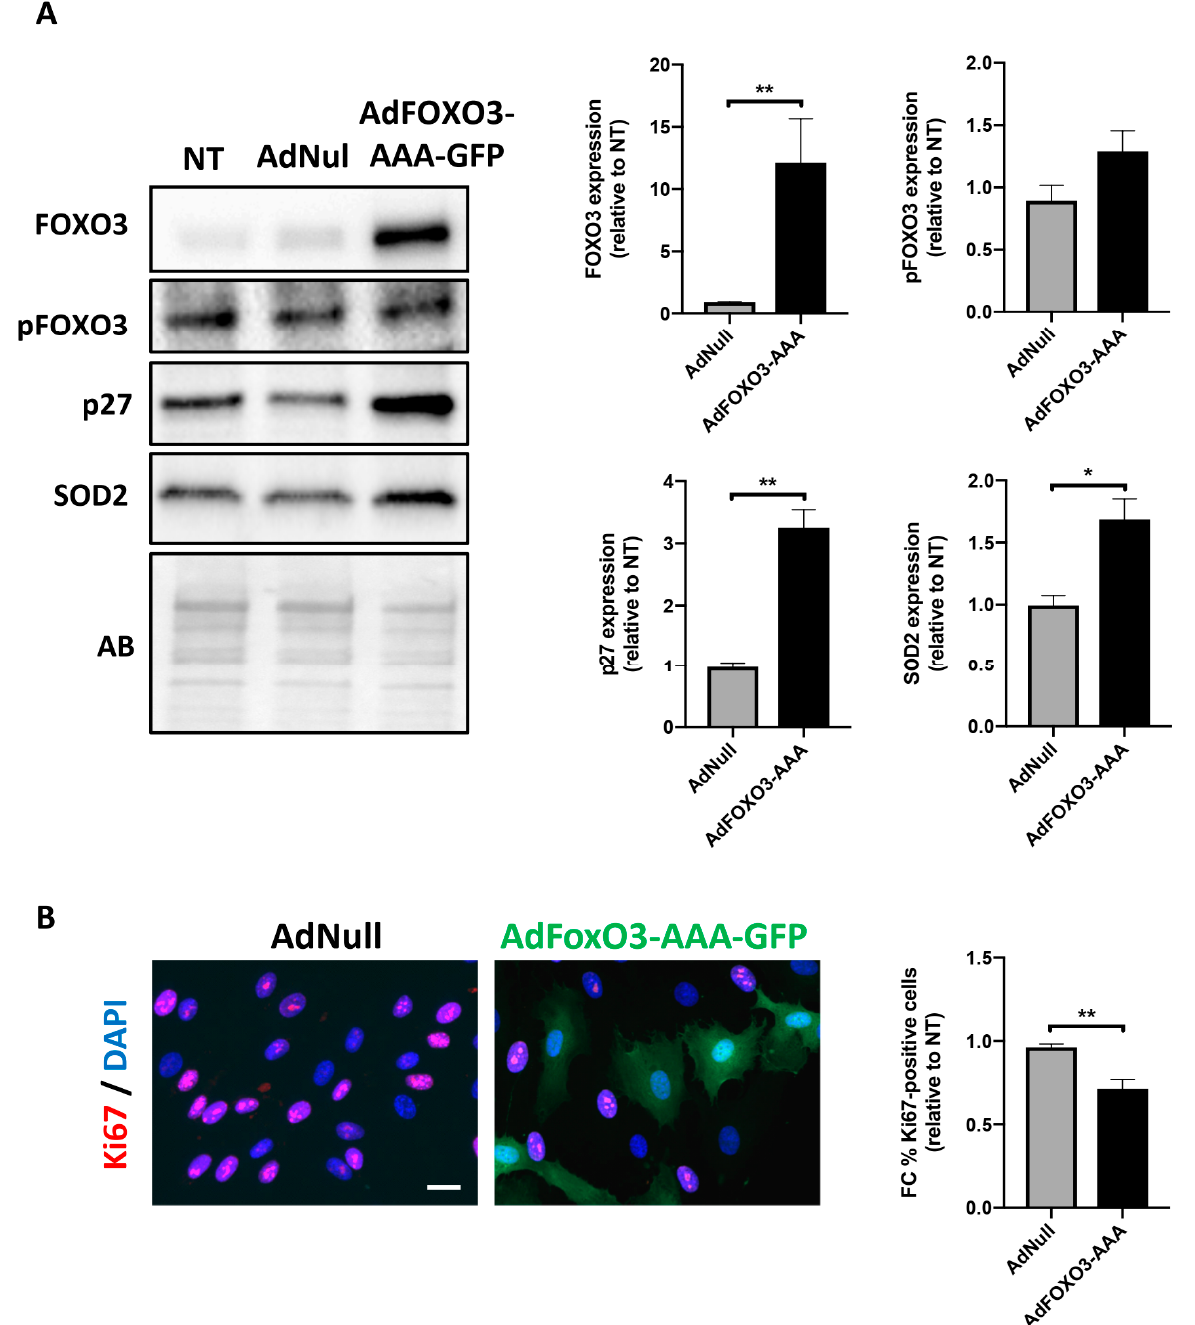
Figure 3 Figure 3. Forced expression of an adenovirus expressing a constitutively active form of FOXO3 reduces PAH-PASMC proliferation. ( A ) Representative Western blots and corresponding densitometric analyses of FOXO3, p(Ser253)-FOXO3, p27 and SOD2 in PAH-PASMCs ( n = 5) infected or not with an adenovirus coding for a non-phosphorylable and constitutively active form of FOXO3 (AdFOXO3-AAA) or an empty adenovirus (AdNull) for 24 h. ( B ) Representative immunofluorescence images of PAH-PASMCs ( n = 5) labeled with Ki67 after infection with AdFOXO3-AAA or AdNull for 24 h. Quantification of the percentage of PAH-PASMCs exhibiting nuclear expression of Ki67 is shown. Data are expressed as fold change (FC) relative to untreated cells and presented as mean ± SEM. Protein expression was normalized to Amido black (AB). * p < 0.05 and ** p < 0.01. Scale bars: 20 µ